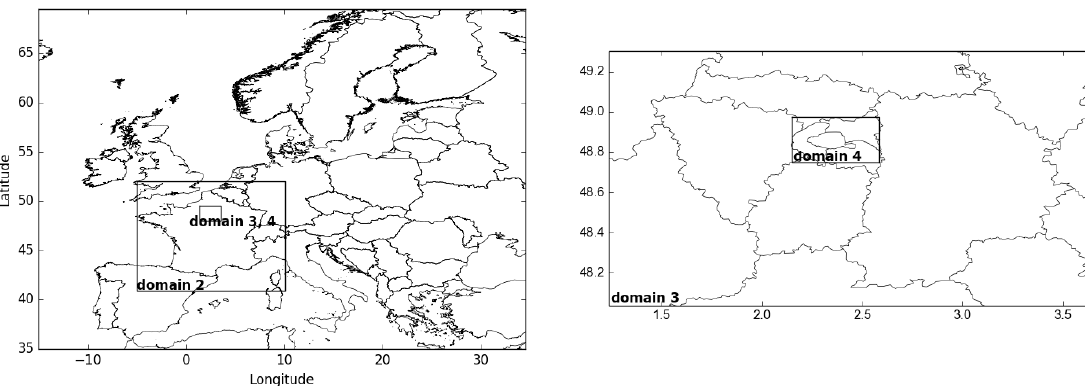
Figure 1. Regional-scale nested domains: Europe (domain 1, spatial resolution 55km × 55km), France (domain 2, spatial resolution 11km × 11km), Île-de-France region (domain 3, spatial resolution 2km × 2km), and Greater Paris (domain 4, spatial resolution 1km × 1km).